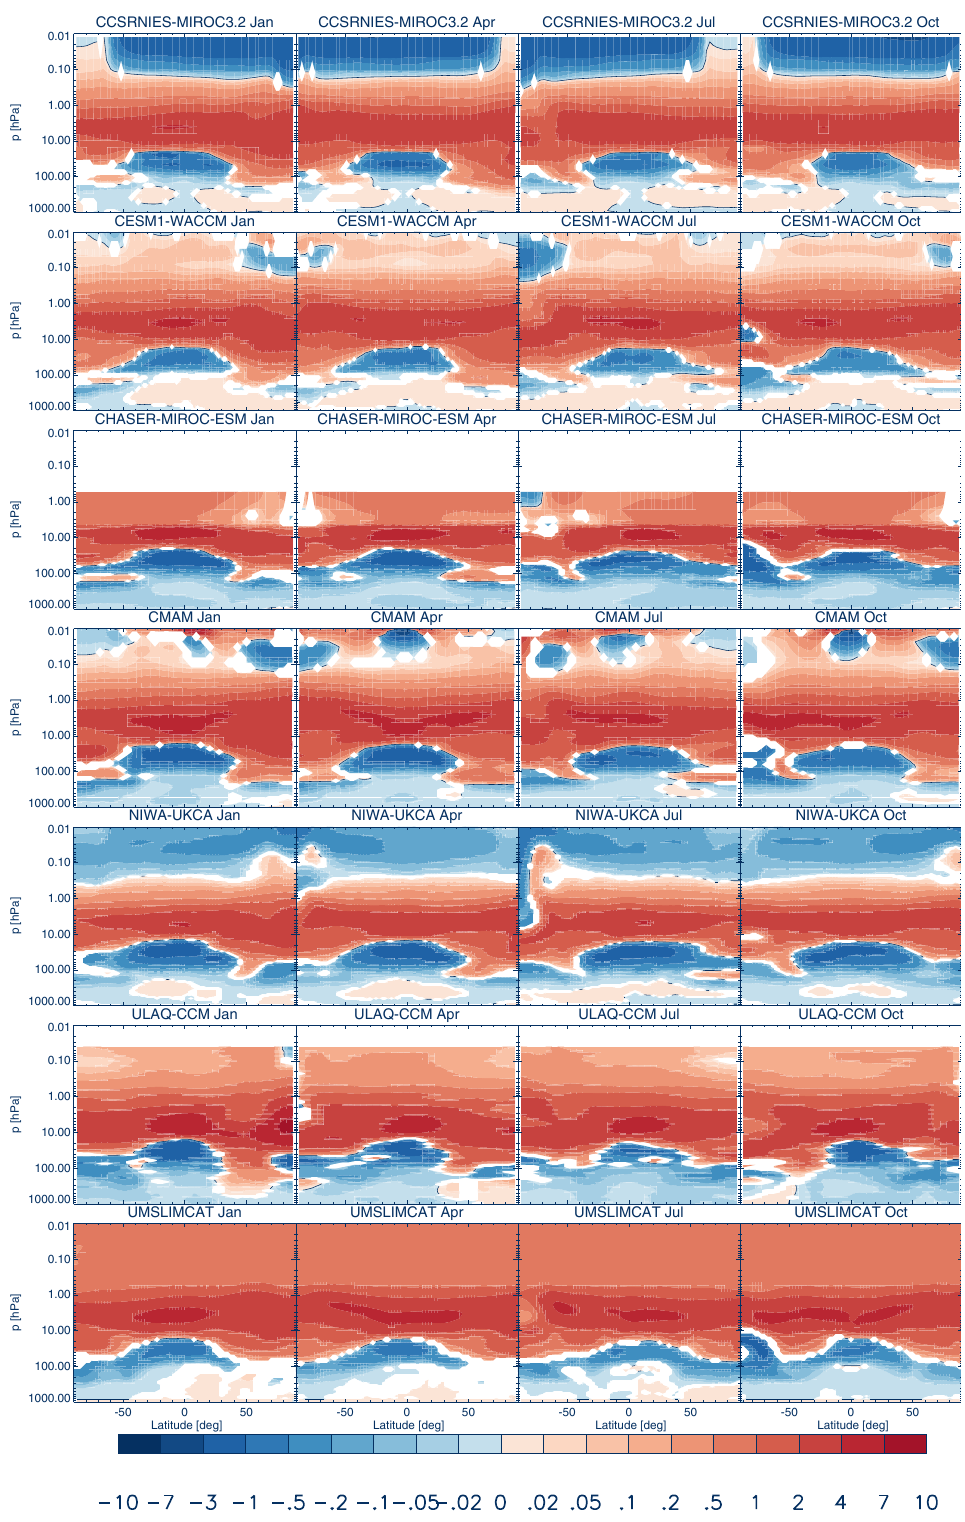
Figure 10. Same as Fig. 1 but for CO 2 eq. Here units are 10 − 3 ppmvppmv − 1